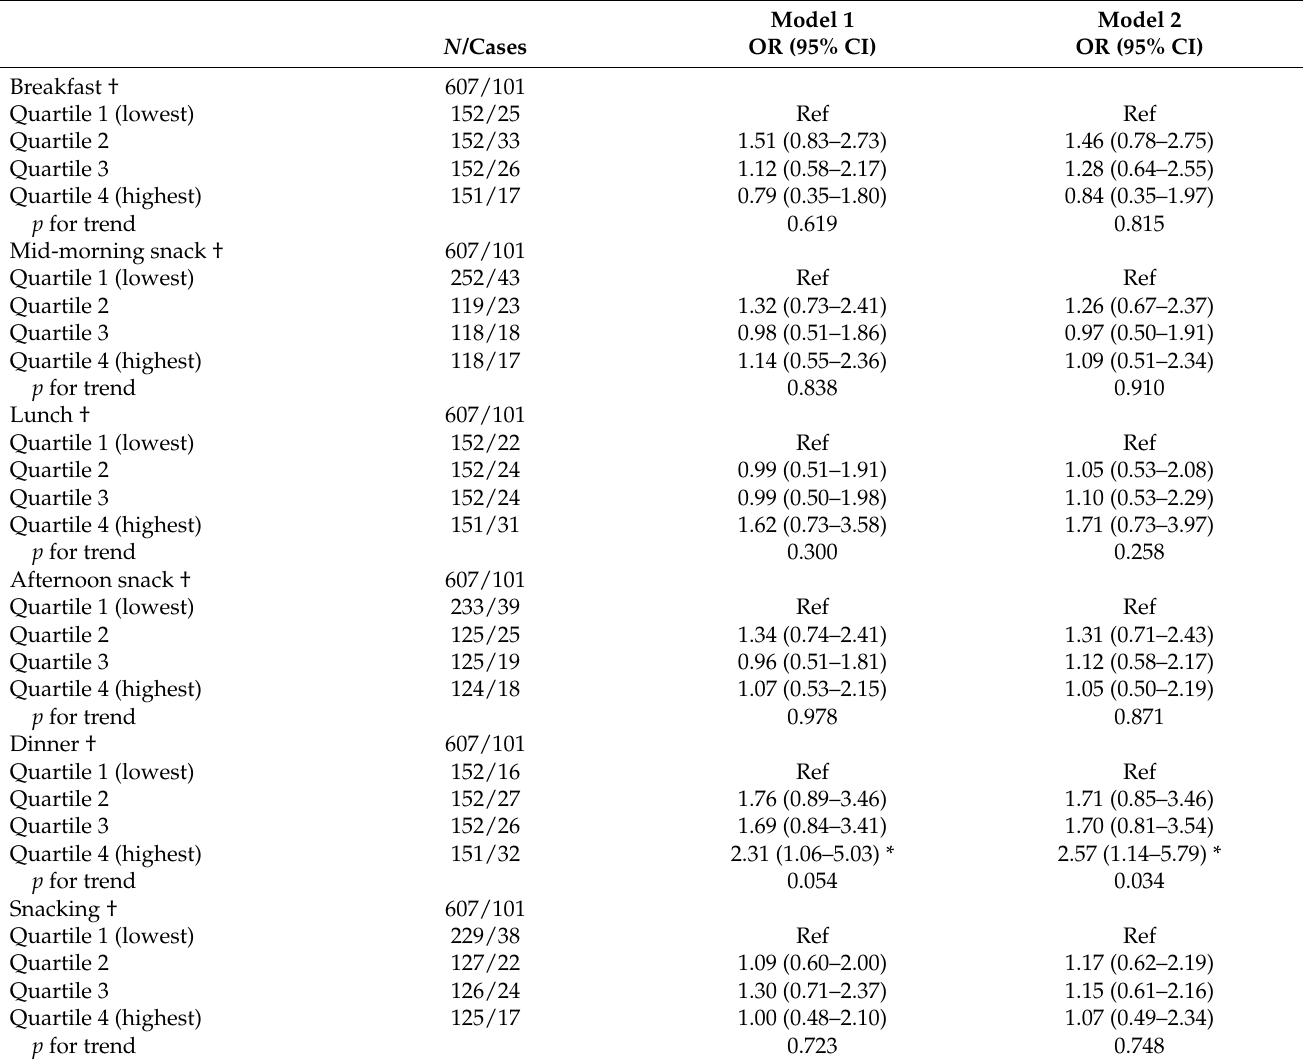
Table 3. Odds ratios (95% confidence interval) for incident metabolic syndrome (2008/10 to 2015) according to sex-specific quartiles of the percentage of energy at each eating occasion among participants in the Seniors-ENRICA-1 cohort study. N =